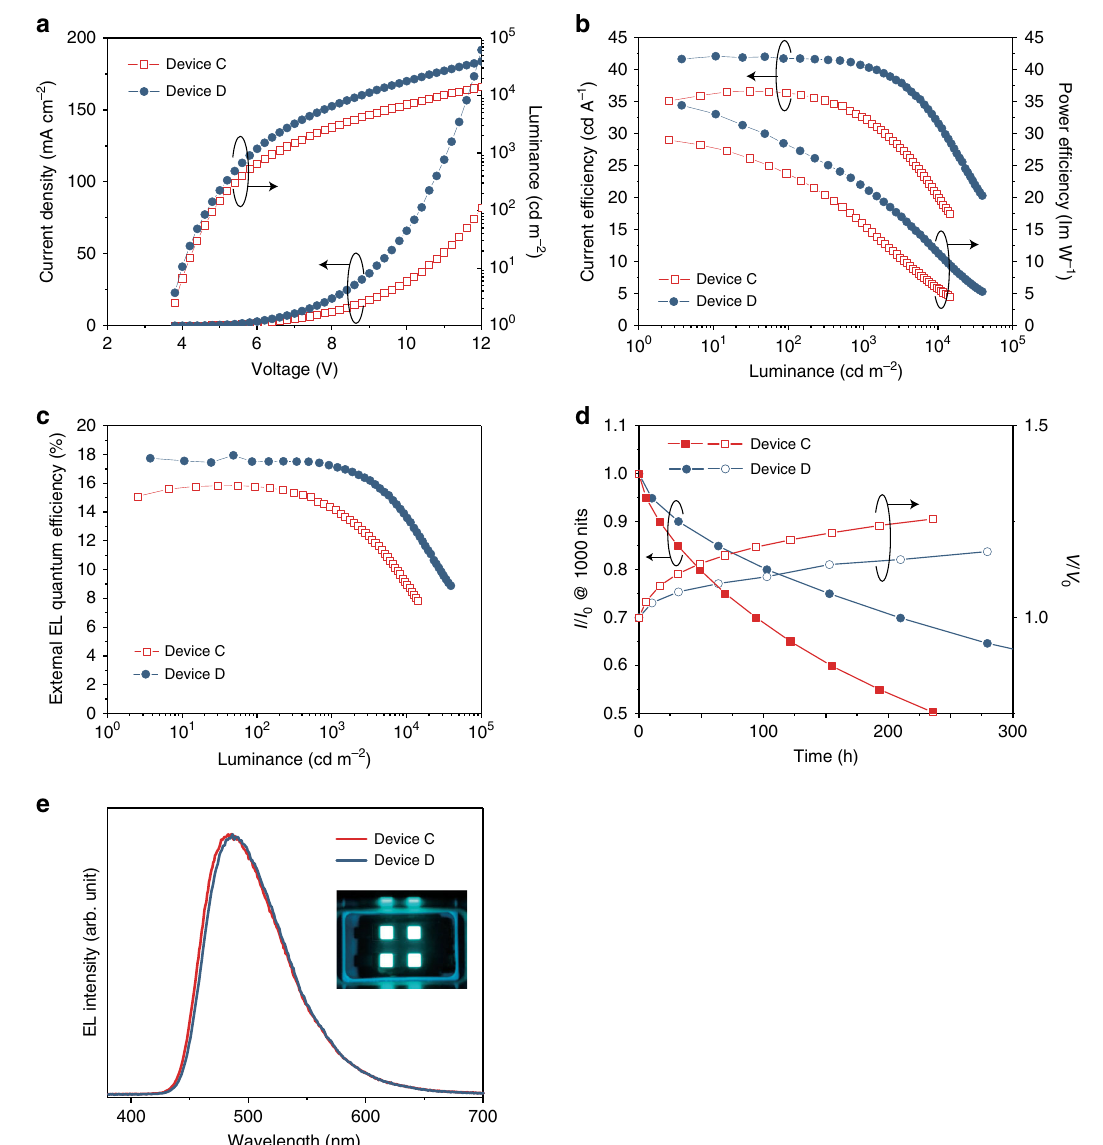
Fig. 3 Device characteristics of device C and D . a Current density and luminance versus voltage. b Power ef fi ciency and current ef fi ciency versus luminance. c External quantum ef fi ciency versus luminance. d Luminance and voltage versus time (at an initial luminance of 1000 cd m − 2 ). Device structure: ITO (100 nm)/ HATCN (10 nm)/ Tris-PCz (30 nm)/ mCBP (5 nm)/ 15 wt% of 3Ph2CzCzBN (device C ) or 20 wt% of 3Ph2CzCzBN (device D ): mCBP (30 nm)/ SF3-TRZ (10 nm)/ 30 wt% of Liq:SF3-TRZ (50 nm)/ Liq (2 nm)/ Al (100 nm). e EL spectra of device C and D and photo of the resulting